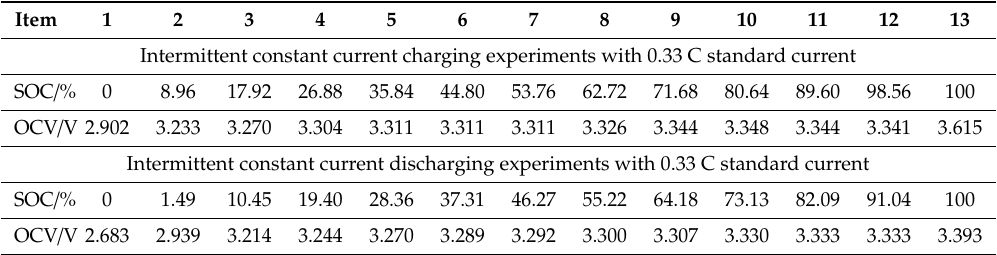
Figure 6. OCV-SOC relationship curve.